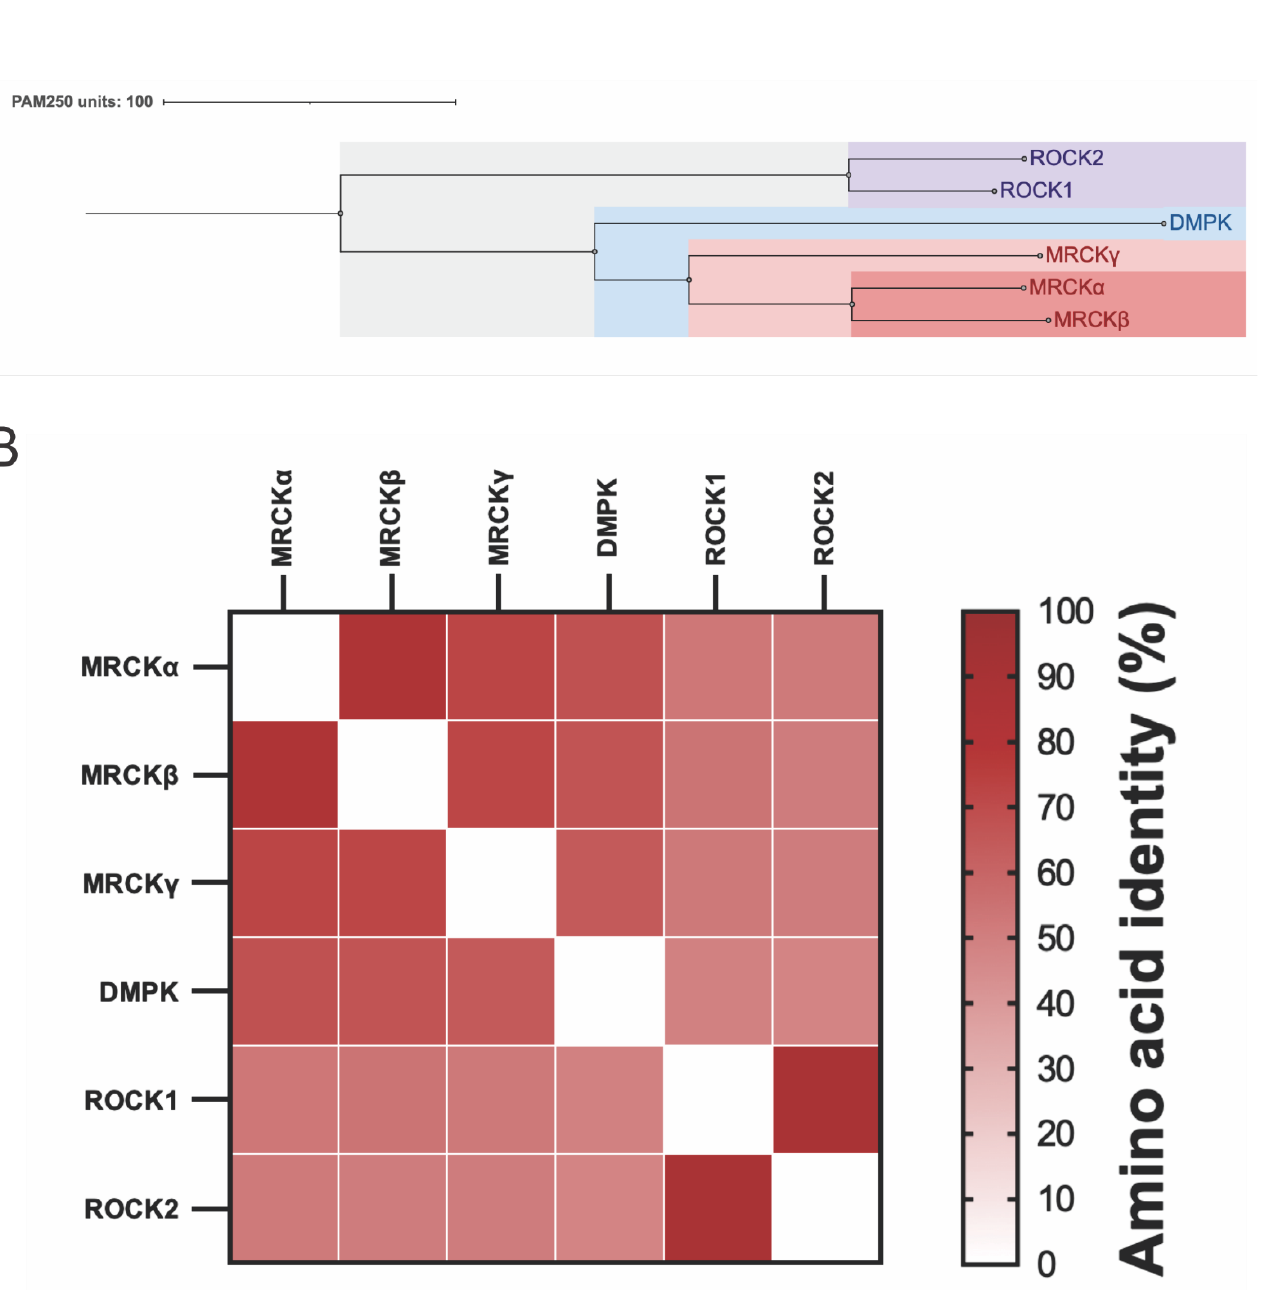
Figure 1. Relatedness of MRCK, ROCK, and DMPK kinases . ( A ). The ROCK1, ROCK2, MRCK α , MRCK β , MRCK γ , and DMPK kinase domains were aligned using protein sequence data from UniProt [16] and ClustalOmega [17]. The results were presented using Jalview [18], and the PAM250 matrix was used to convert the similarity percentages into average distances measured to represent evolutionary distances among the proteins [19]. ( B ). Pairwise alignment of the ROCK1, ROCK2, MRCK α , MRCK β , MRCK γ , and DMPK kinase domains produced percentage identity scores that highlighted the similarities between each kinase domain. These results were graphed as a heat map of their pairwise amino acid identities.